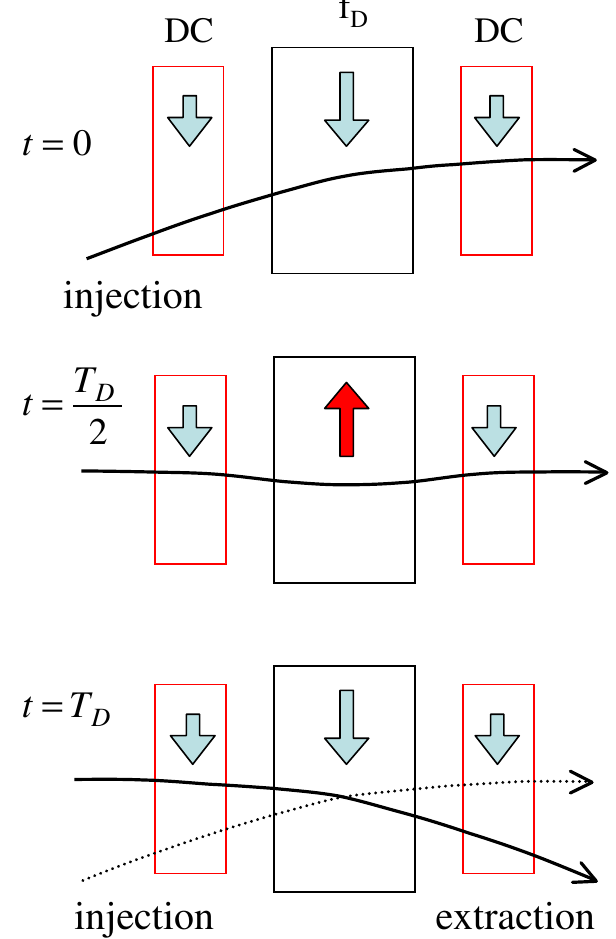
FIG. 3. (Color) Deflection of two-turn system in Fig. 2 at various timings of bunch passages. Arrows indicate deflection directions. At t (cid:3) 0 , deflection directions of cavity and DC magnets are the same and bunch from ERL is injected on axis of ring. At t (cid:3) = 2 when bunch circulates through the first turn in ring, T D deflection directions of cavity is opposite to that of DC magnets, and trajectory of bunch is a chicane. At t (cid:3) T circulates through second turn, deflection is same as t (cid:3) 0 and bunch is extracted from ring to ERL. New bunch is simulta- neously injected into ring.